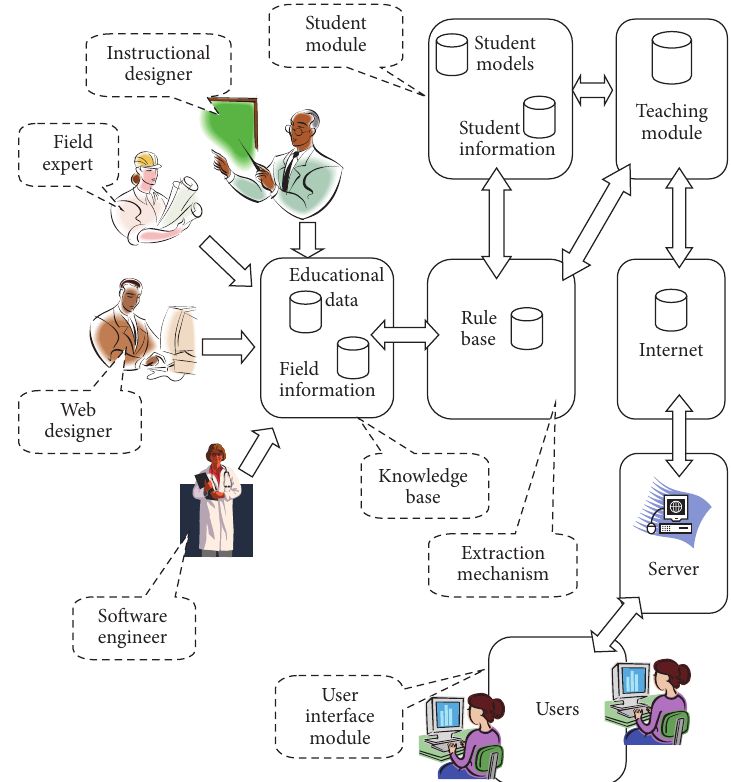
Figure 1: Architectural structure of